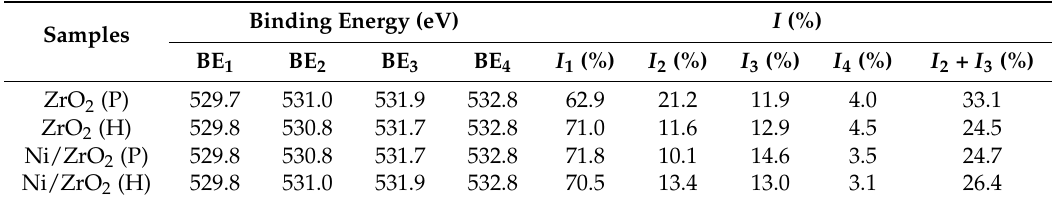
Table 2. The binding energy of O 1s lines and the corresponding surface atomic concentration of ZrO 2 supports and Ni/ZrO 2 catalysts.